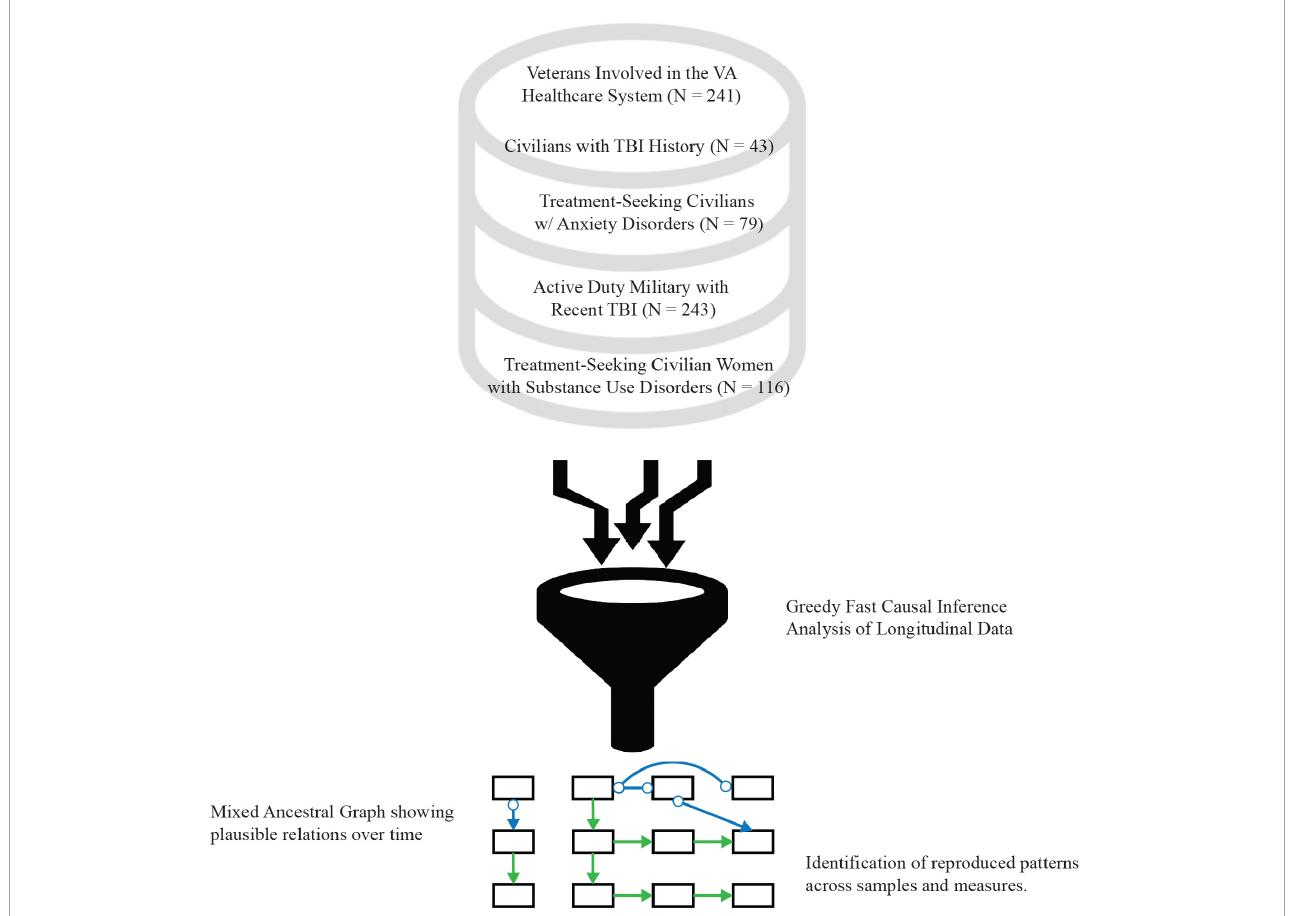
FIGURE1 Study procedural diagram. Data from five separate patient cohorts from different clinical studies were mined for this study, spanning the range of civilians, veterans, and active-duty military populations with posttraumatic stress, substance abuse disorders, traumatic brain injury (TBI), or a combination of multiple of these as the primary diagnosis, with some compared to healthy